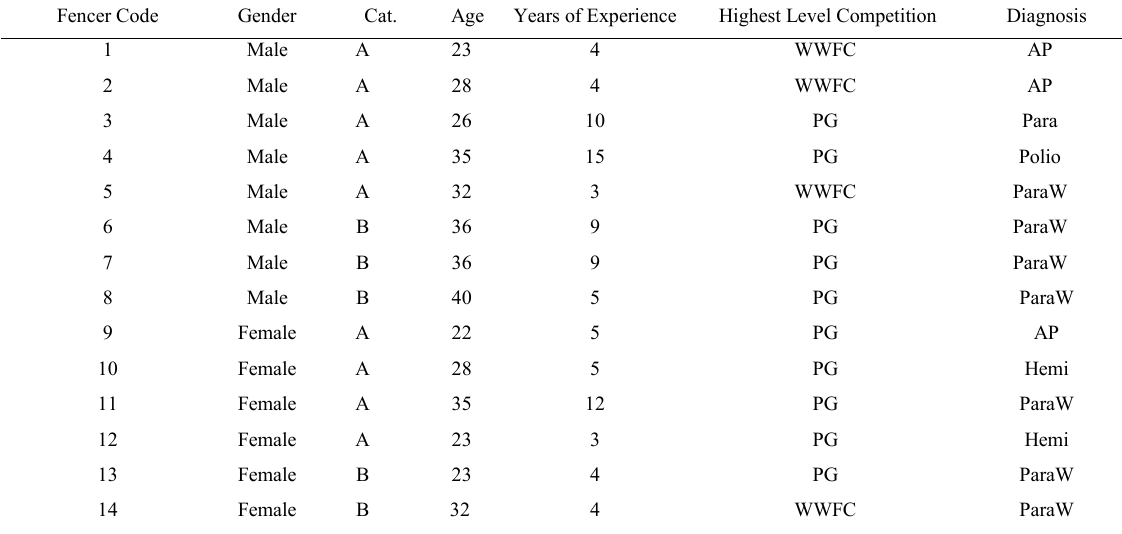
Trunk function ability tests in the two experimental